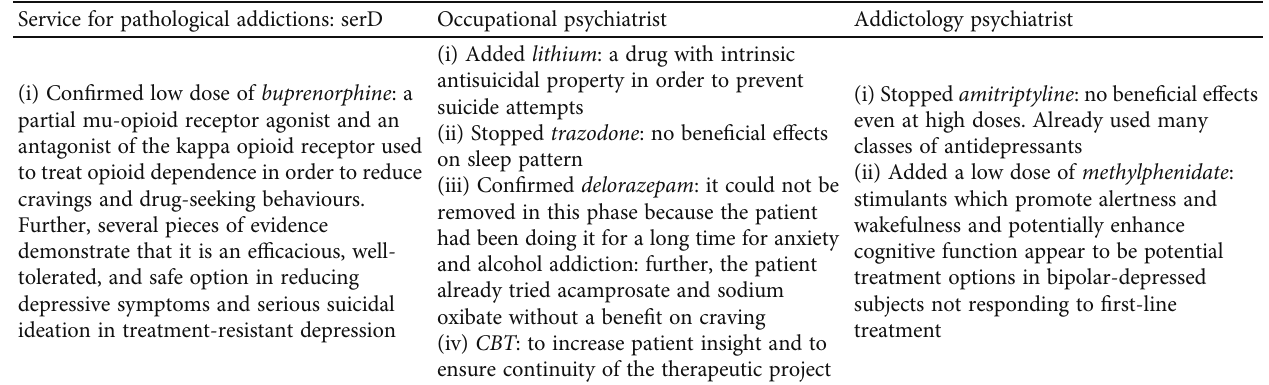
Table 1: Psychiatric treatment